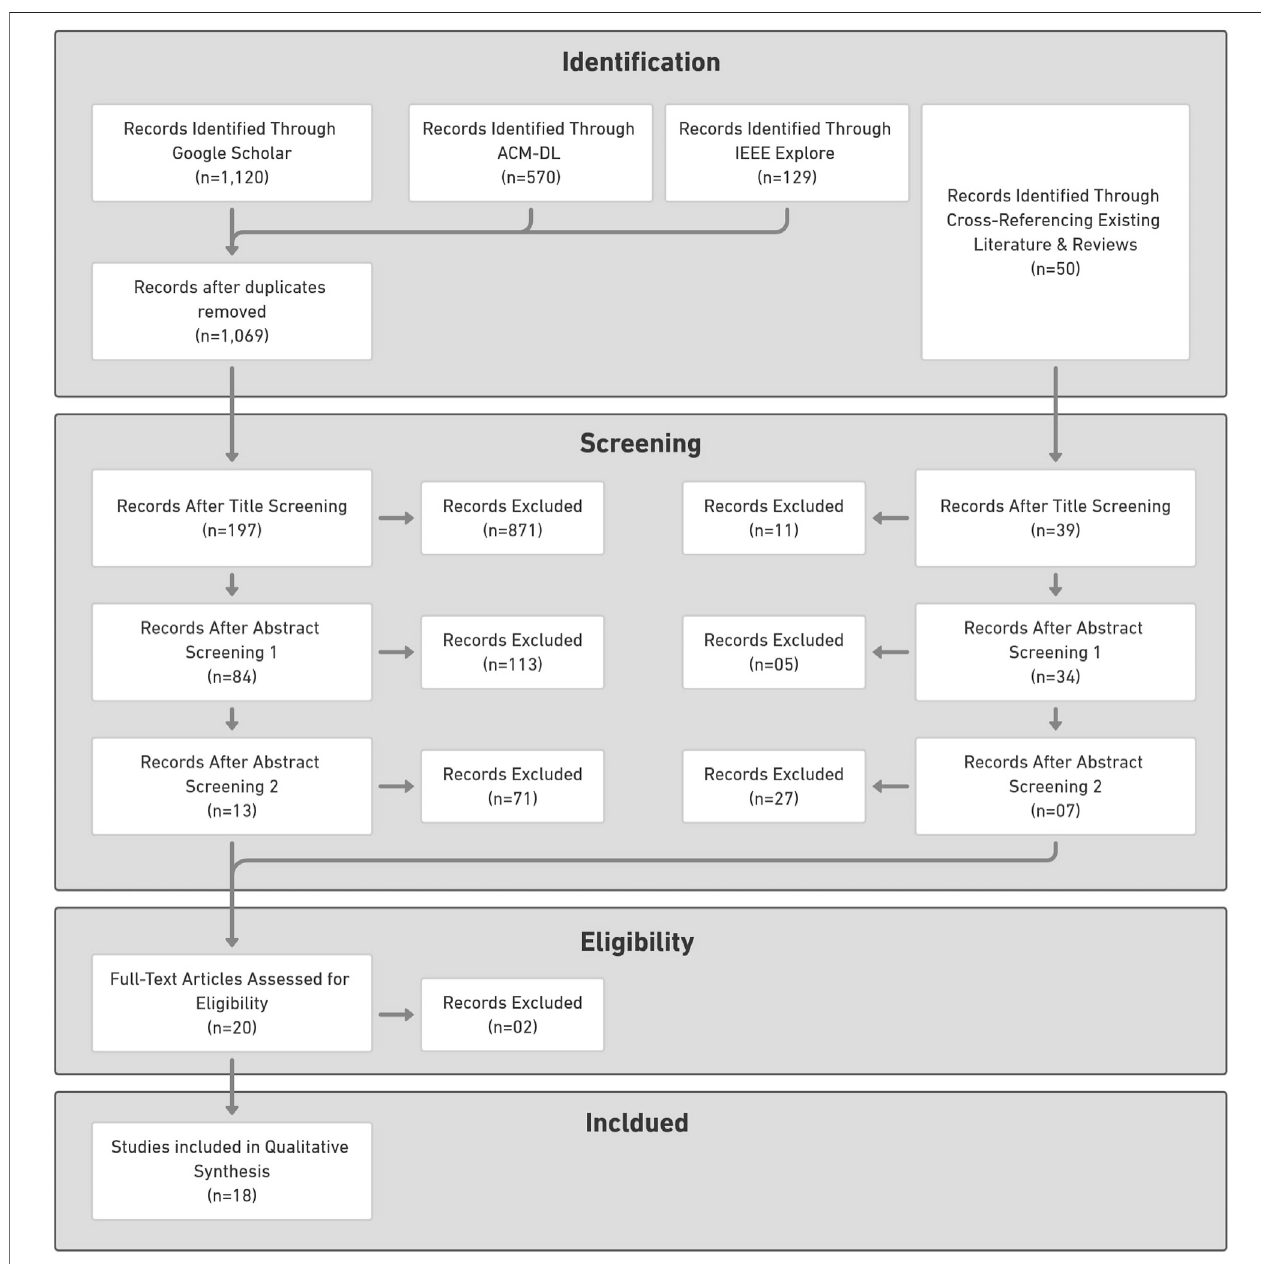
FIGURE 2 | Prisma fl ow diagram of literature review